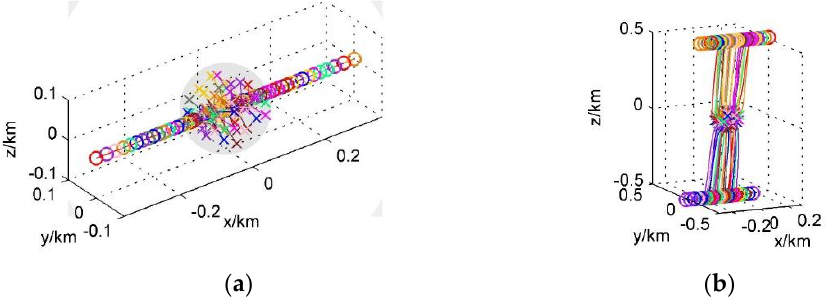
Figure 11. The relative motion trajectory. ( a ) The line formation along 𝑧 = 0 km ; ( b ) The double line formation along 𝑧 = ±0.5 km .